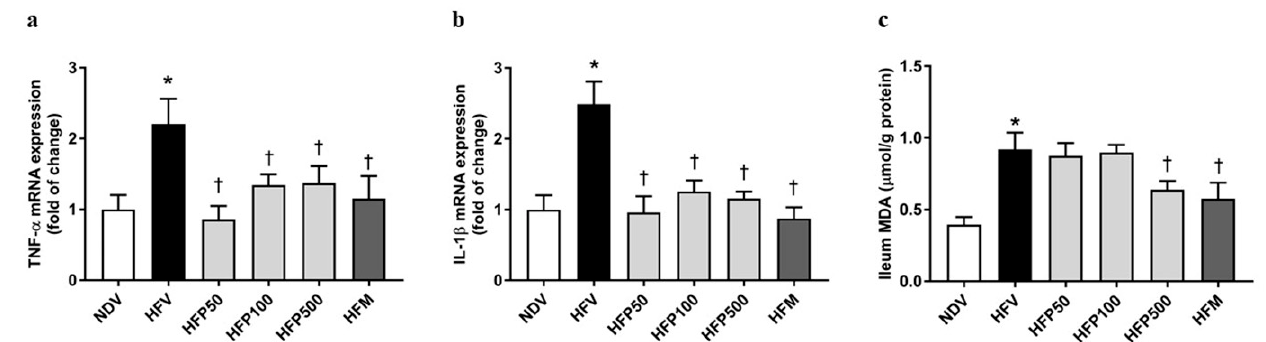
Figure 4. Effect of PSO on intestinal inflammation in obesity-induced insulin-resistant rats. ( a ) TNF- α mRNA expressions; ( b ) IL-1 β mRNA expressions; ( c ) MDA levels. Data are presented as mean ± SEM, * p < 0.05 versus the NDV group; † p < 0.05 versus the HFV group. PSO = Perilla seed oil; TNF- α = Tumor necrosis factor-alpha; IL-1 β = Interleukin 1 beta; MDA = Malondialdehyde; NDV = Normal diet-fed rats treated with the vehicle; HFV = High fat diet-fed rats treated with vehicle.